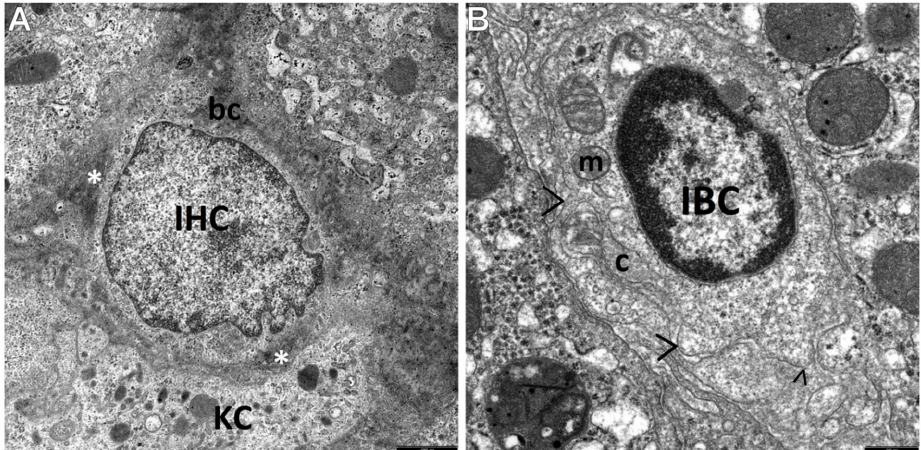
Figure 4. The view of two cells present in the intercellular space (between hepatocytes)—a primitive-looking cell of the HPCL differentiating towards the intermediate hepatocyte-like cell (IHC) and the oval cell differentiating towards the biliary lineage, i.e., the intermediate bile-like cell (IBC) in a liver biopsy obtained from a child with AIH. ( A ) The cell nucleus of the IHC being formed fills up the cell (the nucleus/cytoplasm ratio is evidently shifted for the nucleus), with reduced electron density of chromatin. The cell cytoplasm, forming a very narrow rim around the cell nucleus, filled up with microgranular material, containing the minimum amount of primitive cell organelles; at the upper pole of the cell, a contour of a structure likely to correspond to a very primitive biliary canaliculus—hemicanaliculus (bc). Hyperactive Kupffer cell/macrophage (KC) containing numerous phagosomes adheres to its bottom pole. Around the IHC and the KC, the presence of a flocculent, condensed extracellular matrix (*), which can be referred to as the morphological precursor of collagen. Scale bar: 1 µm. ( B ) Within the IBC cytoplasm, the presence of rare primitive-looking organelles, mainly mitochondria and elements of the smooth endoplasmic reticulum; the nucleus/cytoplasm ratio markedly shifted for the cell nucleus. The cell has well-developed plasma membrane filopodia (>), well-developed basal membrane and pinocytotic vacuoles; visible is the transverse section through the bundle of mature collagen fibers (c) closely adhering to the cell. Scale bar: 0.5 µm.